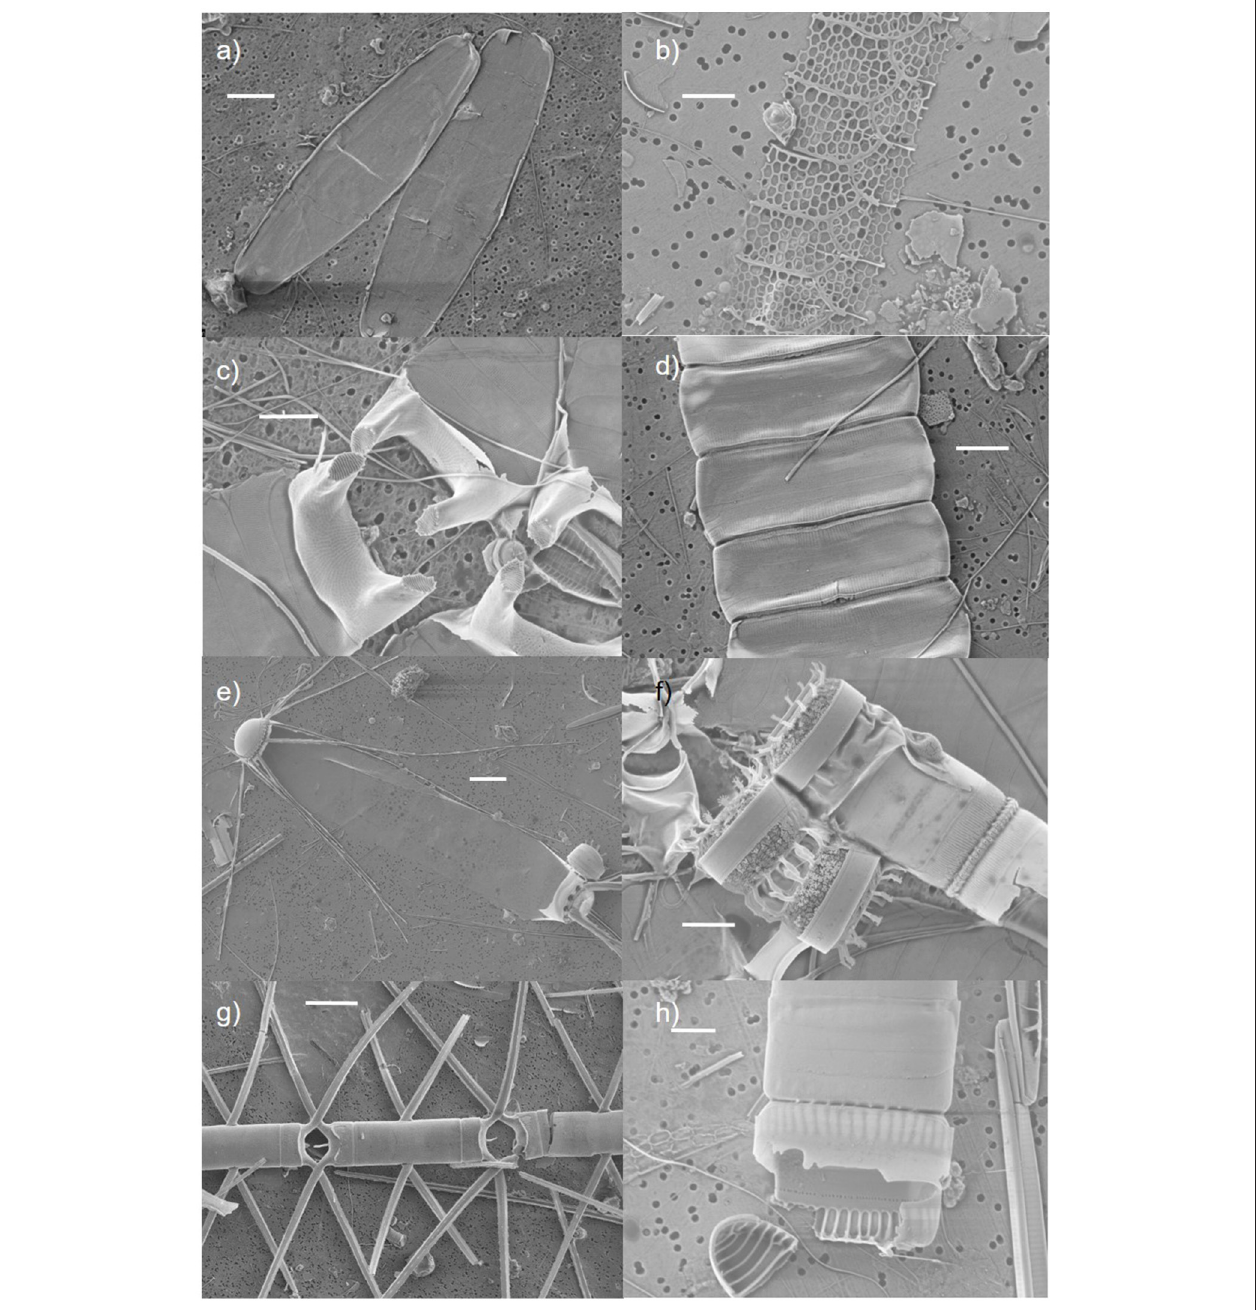
FIGURE 2 | Diatom species images from the Scanning Electron Microscope (SEM). Examples of diatoms considered (1) weakly: (a) Ephemera planamembranacea , (b) Leptocylindrus mediterraneous , (c) Eucampia groenlandica , (2) moderately: (d) Pauliella taeniata , (e) Corethron criophilum , or (3) heavily silicified (f) Detonula confervacea , (g) Chaetoceros atlanticus , (h) Neodenticula seminae . Scale bars are 5 µ m in figures (a – d , f , h) and 30 µ m in (e , g) . A principal component analyses (PCA, Primer-E v.7) was was performed to fulfill the premise of linearity in the PCA.